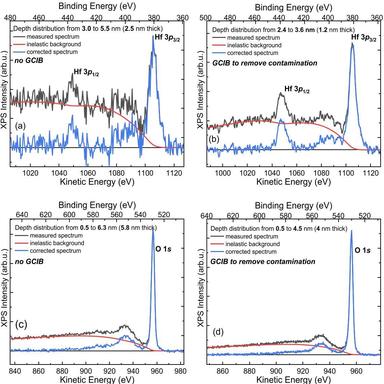
QUASES-Analyze IBA for the ALD bilayer stack: HfO2 (1.5 nm) buried under Al2O3 (2 nm) before and after GCIB treatment. The black line is the raw measured spectrum, the red line is the calculated inelastic background, and the blue line is the spectrum corrected for inelastic losses by subtracting the red line. (For interpretation of the references to colour in this figure legend, the reader is referred to the web version of this article.)